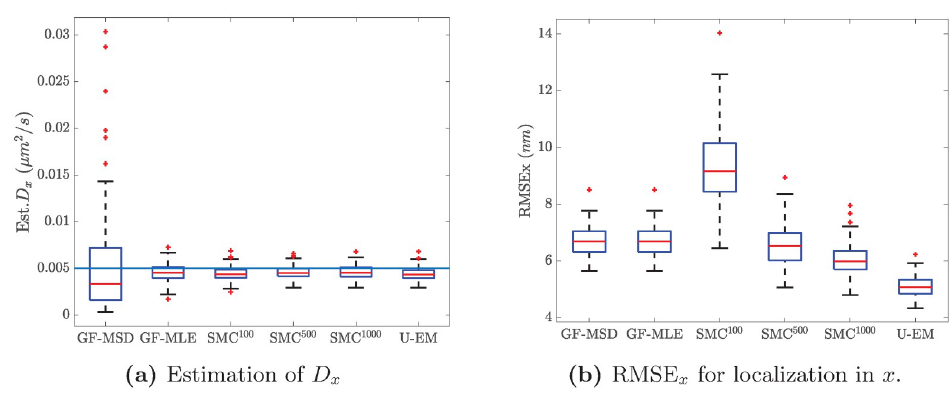
Fig 6. Performance comparison among the different analysis methods. With G = 100, N bgd = 10, D x = 0.005 μ m 2 /s, and D = 0.01 μ m 2 /s. (a) Box plot results for the estimate of D y